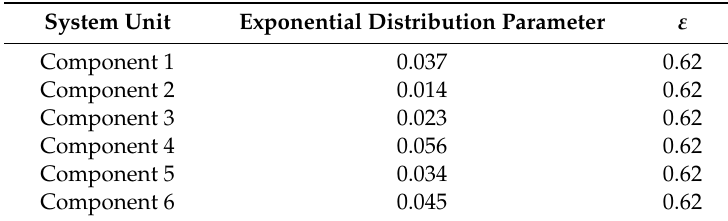
Table 1. Estimated values of the model parameters.